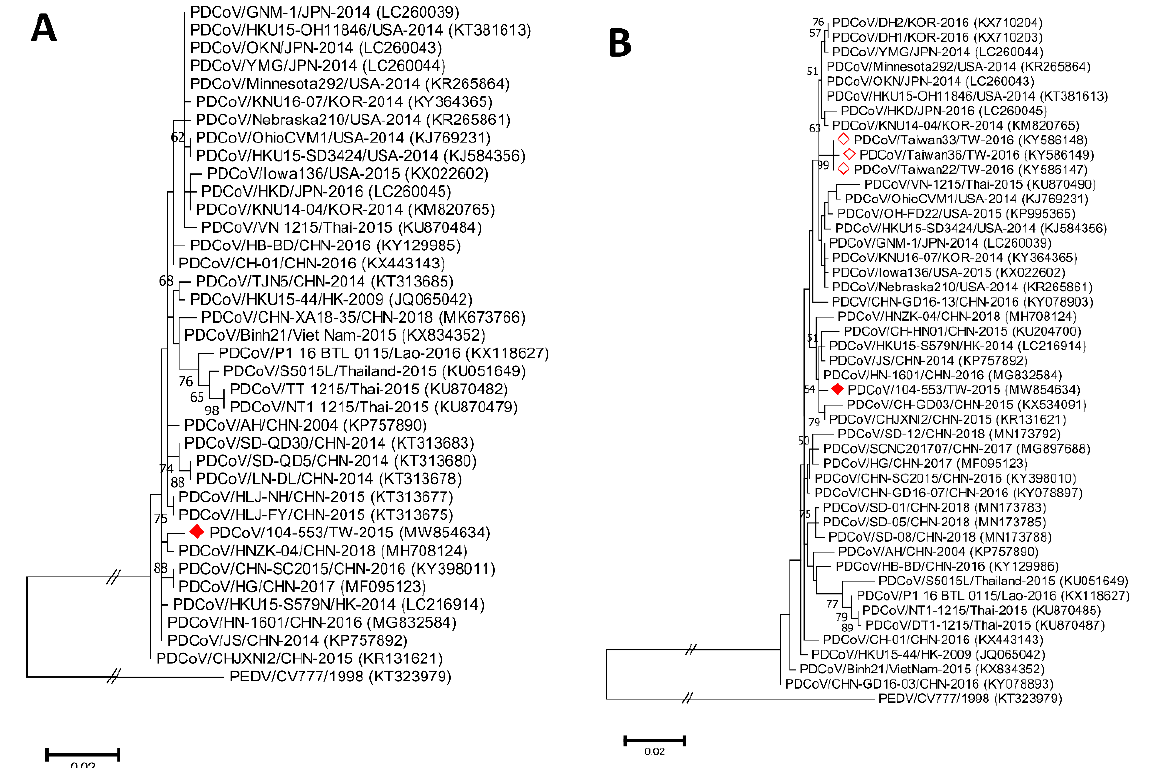
Figure 3. Phylogenetic trees based on the M ( A ) and N ( B ) genes of PDCoV strains were generated from maximum likelihood estimation (MLE), using the Kimura 2-parameter (K2P) model. Horizontal branch lengths represent genetic distances among various strains from different genogroups. The red solid diamond represents the local PDCoV isolate in this study. The red-outlined diamond indicates historical PDCoV strains in Taiwan.